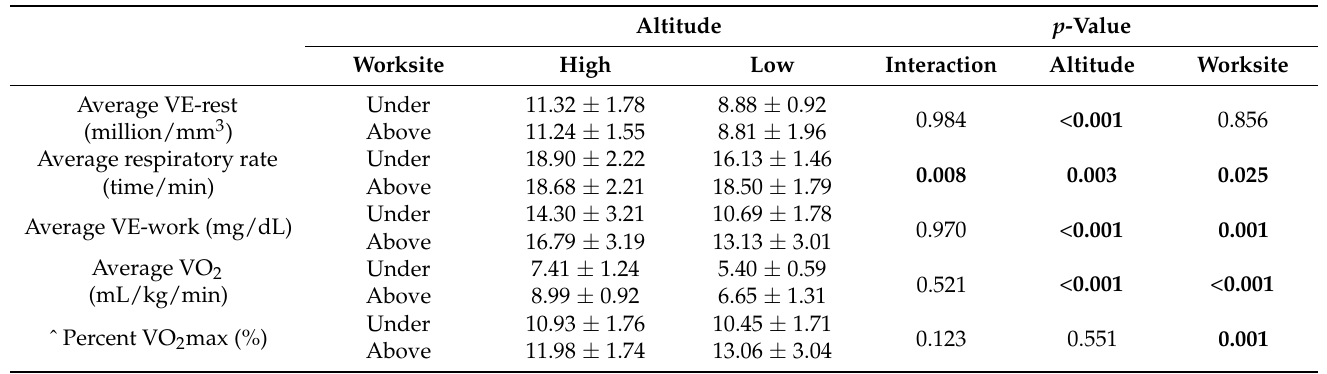
Table 5. Pulmonary function